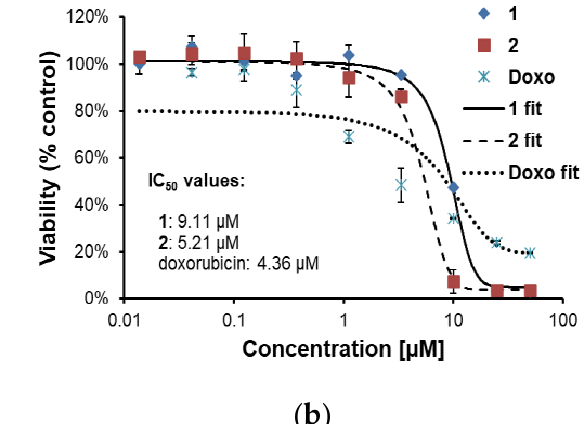
Figure 2. Viabilities of osteosarcoma cell lines U-2 OS (wild-type p53 status) and SAOS-2 (with p53 deletion) after 24 h treatment with 1 , 2 and doxorubicin (Doxo): ( a ) U-2 OS cells; ( b ) SAOS-2 cells.